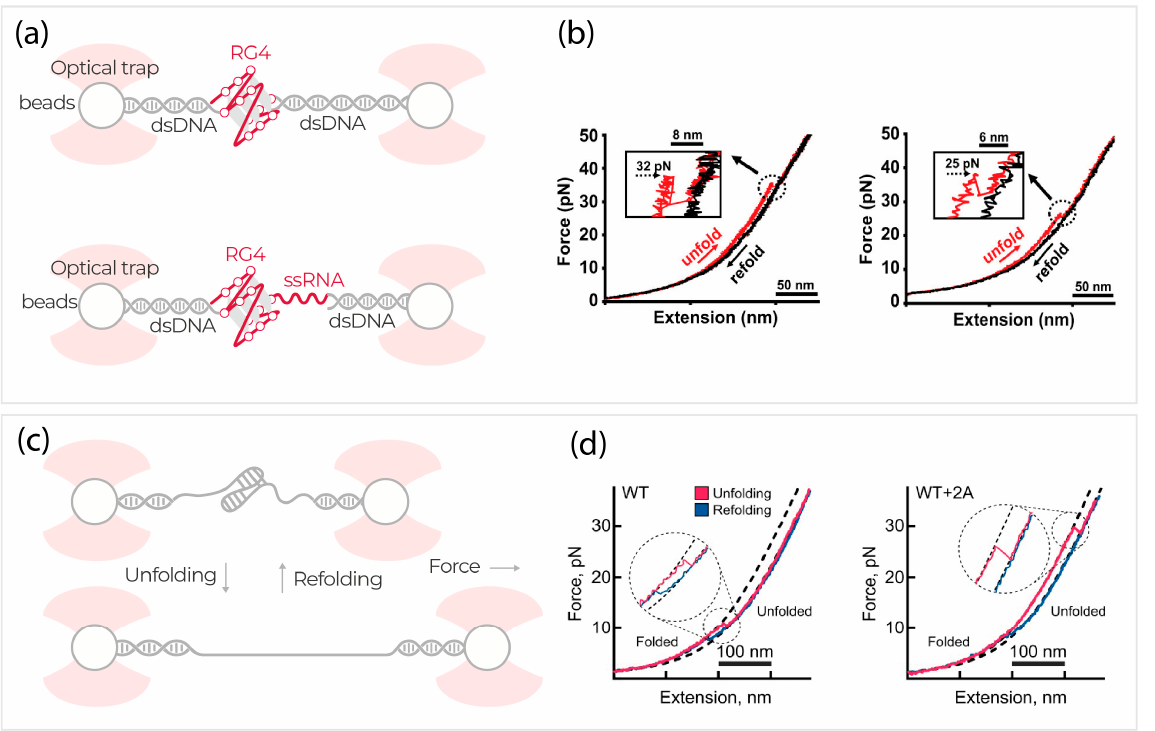
Figure 3. Overview of understanding various RNA structure dynamics using optical tweezers. ( a ) Schematic representation of RNA G-quadruplex (RG4) formed using single-stranded RNA (ssRNA) sequences without and with a proximal ssRNA extension, tethered between two optically trapped beads through double-stranded DNA. ( b ) Corresponding force-extension plots illustrate that the addition of a proximal ssRNA extension to RG4 weakens its mechanical stability by reducing the rupture force for the RG4. Adapted with permission from [53]. Copyright (2021) American Chemical Society. ( c ) Schematic representation of folded and unfolded RNA pseudoknot structures tethered between two optically trapped beads. ( d ) Corresponding force-extension plots illustrate that − 1 PRF regulating protein 2A interacts with the RNA pseudoknot and increases its mechanical stability to promote − 1 PRF controlled translation. Adapted with permission from reference [112] Copyright (2021) Springer Nature.